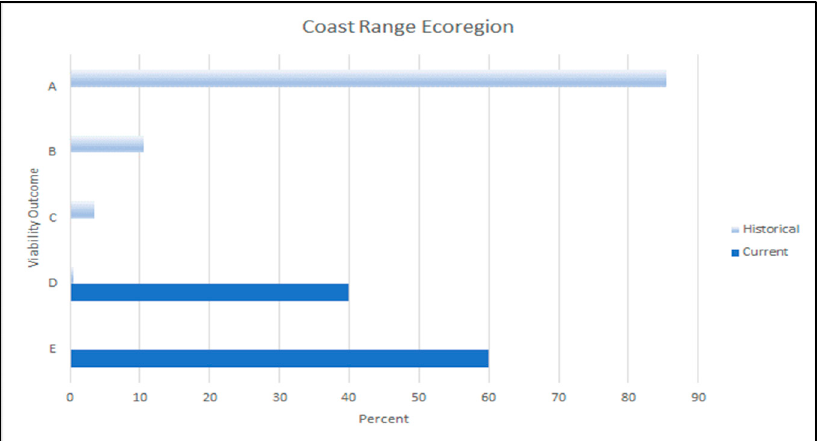
Figure 8. Historical (light blue bars) and current (dark blue bars) viability outcomes for red tree voles ( Arborimus longicaudus ) in the Coast Range ecoregion in Oregon, USA. Viability outcomes are described in Table 4.